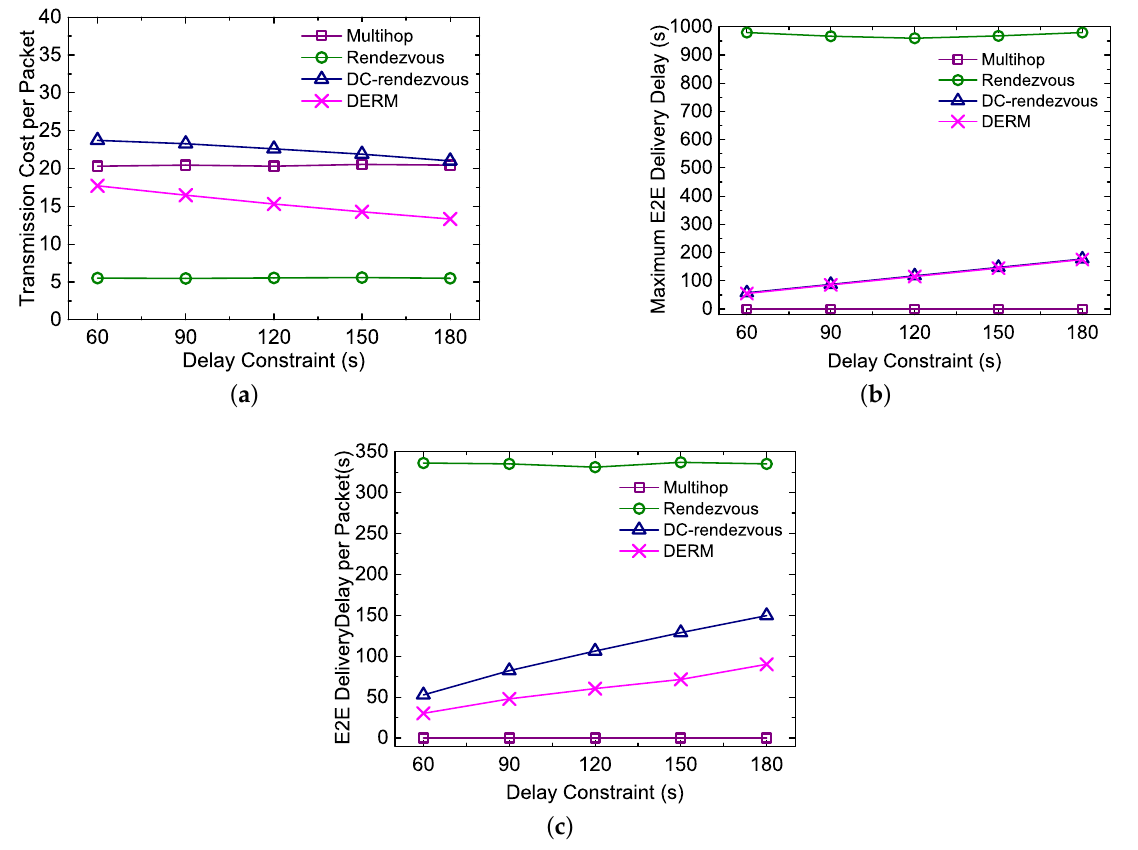
Figure 9. Impact of the delay constraint on the performance of four routing schemes ( v M = 2 m/s). ( a ) transmission cost per packet; ( b ) maximum end-to-end delivery delay; ( c ) end-to-end delivery delay per